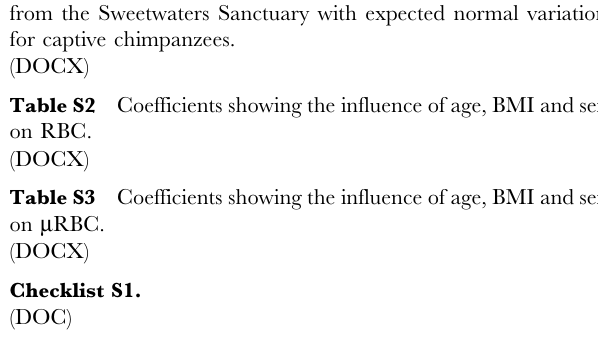
Table S1 Comparison of selected hematological parameters from the Sweetwaters Sanctuary with expected normal variation for captive chimpanzees. Table S2 Coefficients showing the influence of age, BMI and sex on RBC. Table S3 Coefficients showing the influence of age, BMI and sex on m